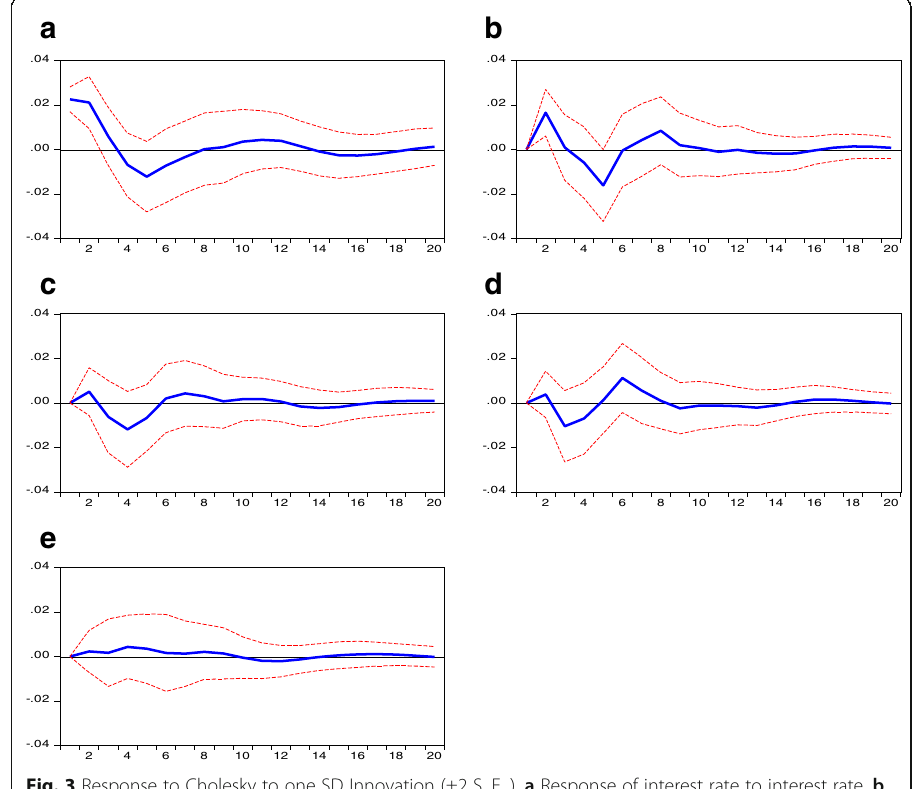
Fig. 3 Response to Cholesky to one SD Innovation (±2 S. E. ). a Response of interest rate to interest rate. b Response of interest rate to M2 money growth. c Response of interest rate to income growth. c